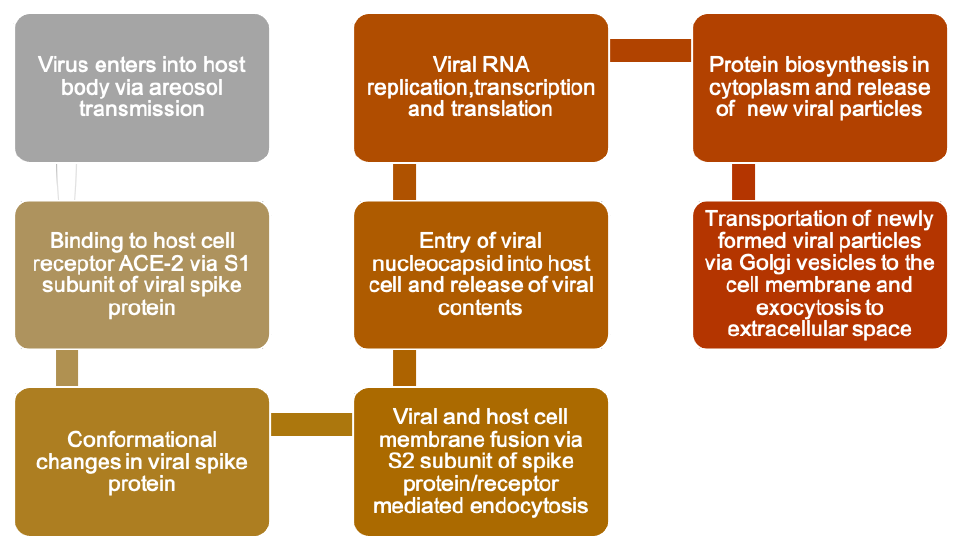
Figure 1. SARS-CoV-2 life cycle showing virus behaviour inside the body [21].